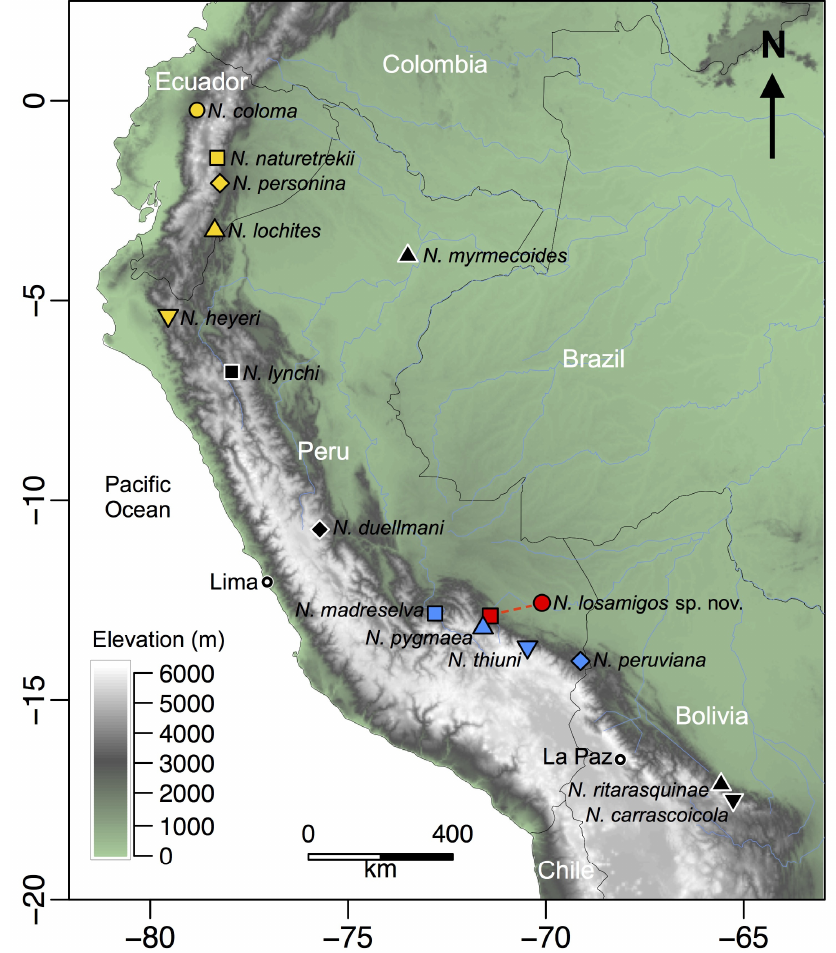
Figure 12. Map of northwestern South America showing the location of the type localities of species in the genus Noblella . The red circle indicates the type locality of Noblella losamigos sp. n. and the red square indicates the collecting site of paratypes in San Pedro, Kosñipata Valley.